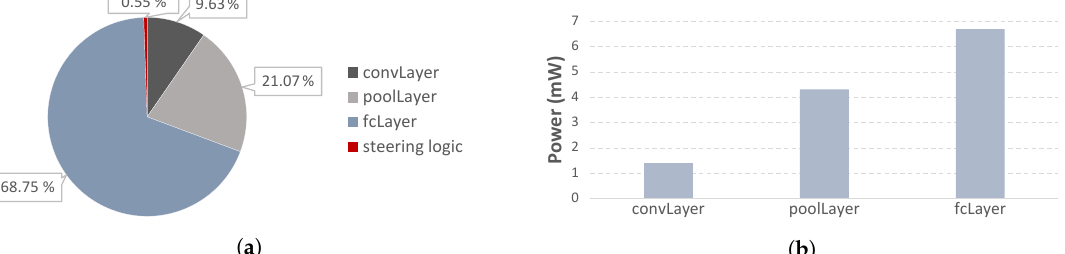
Figure 6. Standard-cell-based ASIC accelerator of the LeNet inference engine, synthesized at the critical path delay (1.93 ns): area percentage and power consumption per layer. ( a ) Area percentage per layer. ( b ) Mean power per layer.